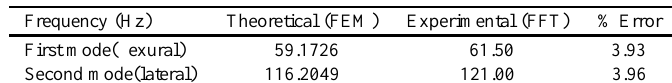
Table 3 Structural frequency of box girder